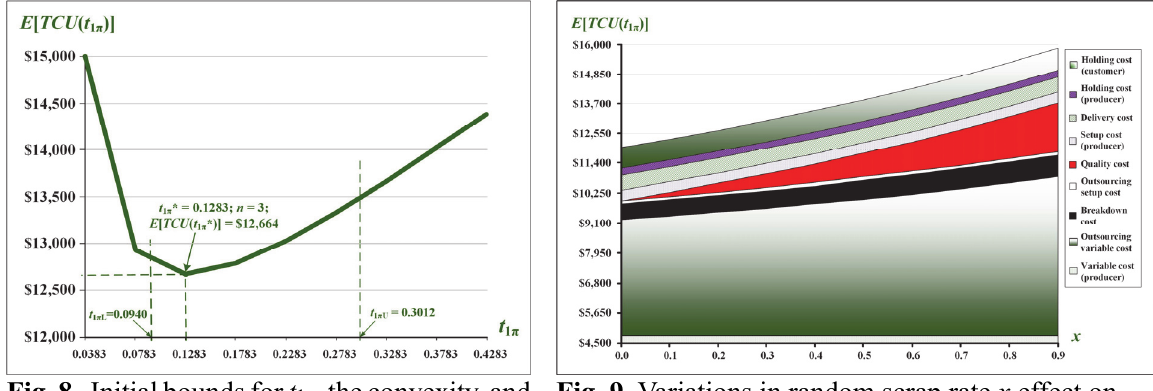
the effect of deviations in t 1 π on E [ TCU ( t 1 π )]